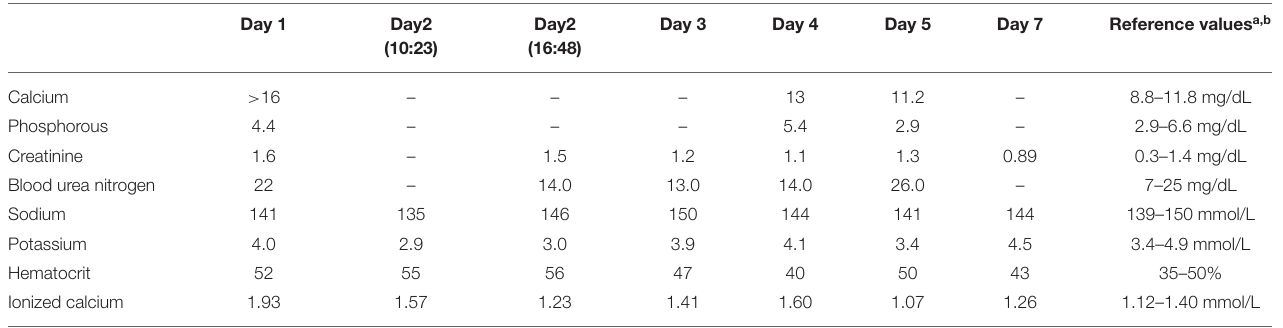
TABLE 1 | Serial serum biochemical parameters, ionized calcium concentration, and hematocrit in a dog with cholecalciferol rodenticide toxicosis starting at the time of initial presentation (day 1) until the day of discharge (day